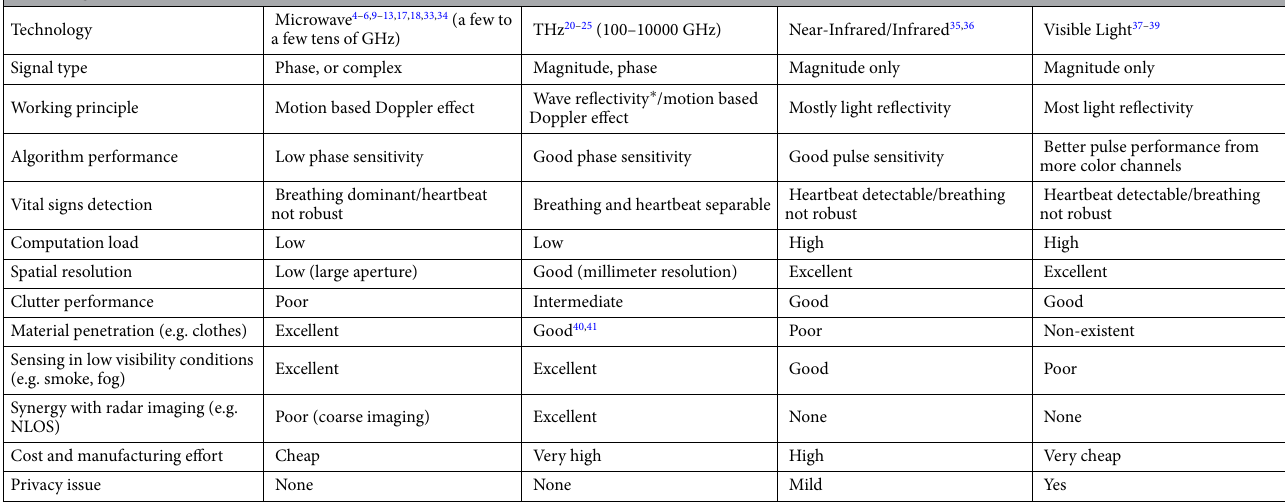
Table 1. Summary the key features of EM frequencies for vital sign detection.